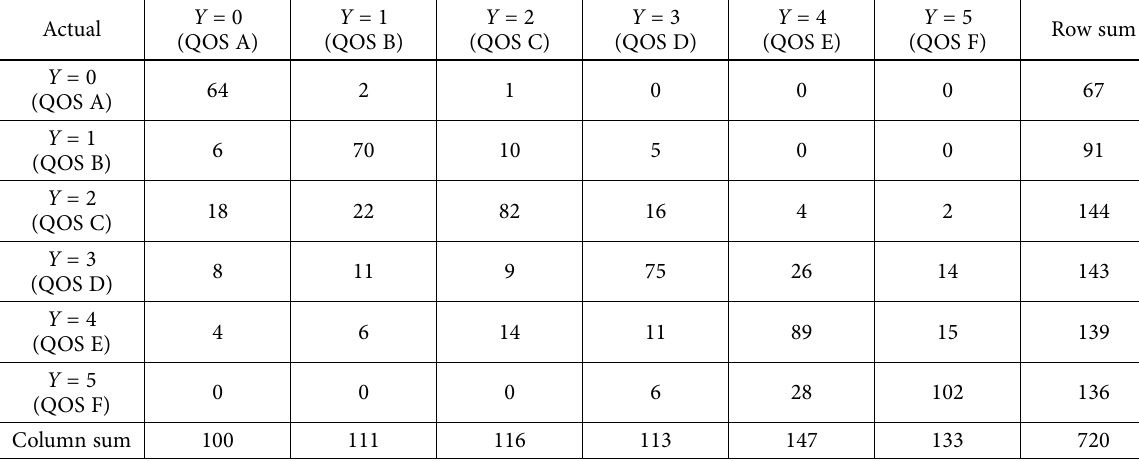
Table 6. QOS Model validation results